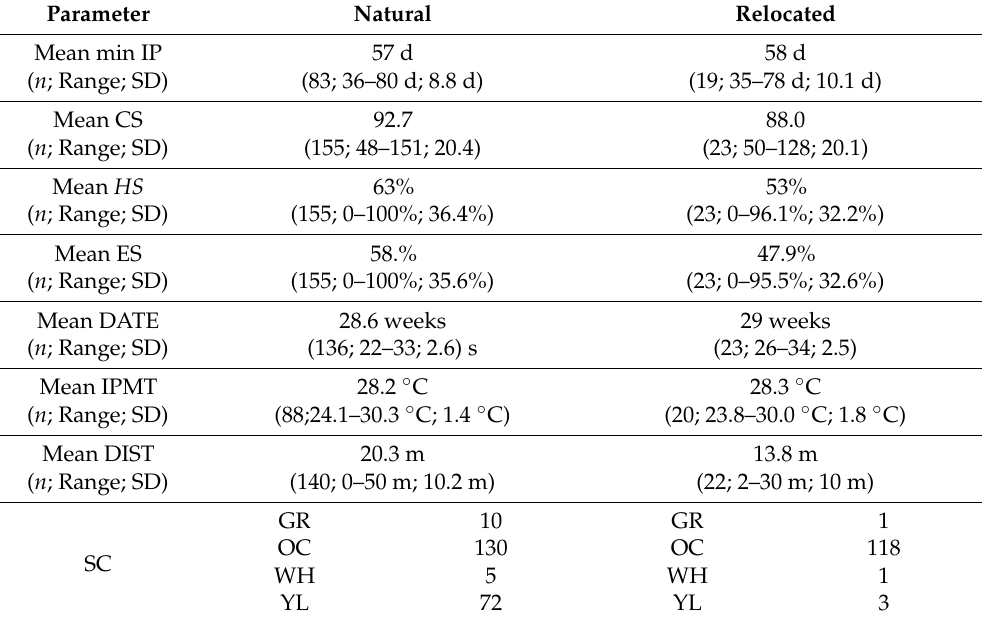
Table 1. Reproductive parameters of 217 natural and 23 relocated nests of loggerhead turtles found in Sicily from 1944 to 2021. The other 63 nests were reported for which these parameters were not available. IP, incubation period; CS, clutch size; HS , hatching success; ES, emergence success; DATE, week of nesting; IPMT, incubation period mean air temperature; DIST, distance of the nest from